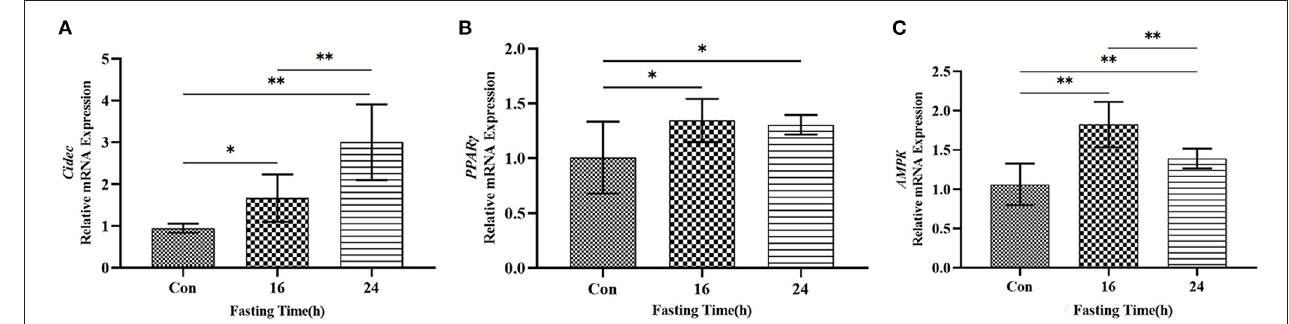
FIGURE 7 | Expression of Cidec, PPAR γ and AMPK in a starvation cell model. (A) mRNA expression of Cidec in starved AML12 cells. (B) mRNA expression of PPAR γ in starved AML12 cells. (C) mRNA expression of AMPK in starved AML12 cells. T-test analysis was used for data statistics. β -actin was used as the internal control. Data were analyzed by t-test. * P < 0.05, ** P <